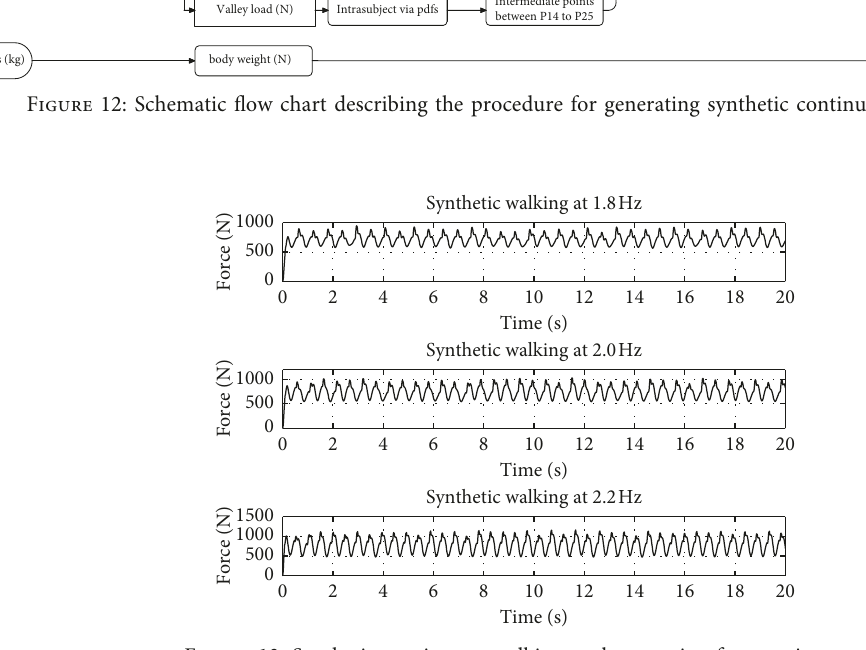
Figure 13: Synthetic continuous walking at three pacing frequencies.